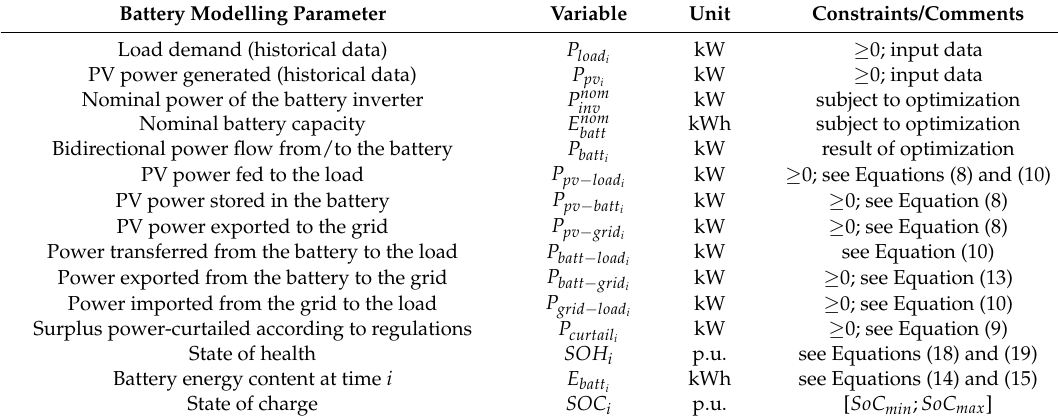
Table 5. Variables and parameters used for the battery modeling and optimization